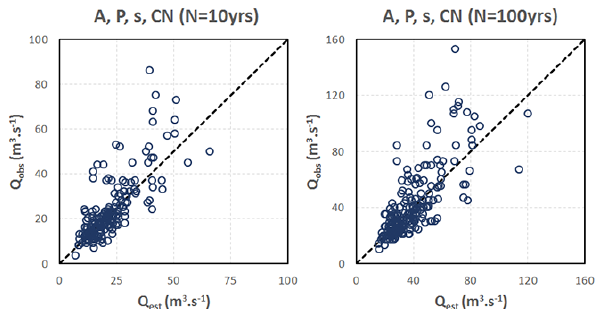
Figure 12. Scatterplot of observed versus estimated discharge val- ues for a combination of catchment area, maximum daily pre- cipitation total, average catchment slope and curve number for T = 10 years (left panel) and T = 100 years (right panel).